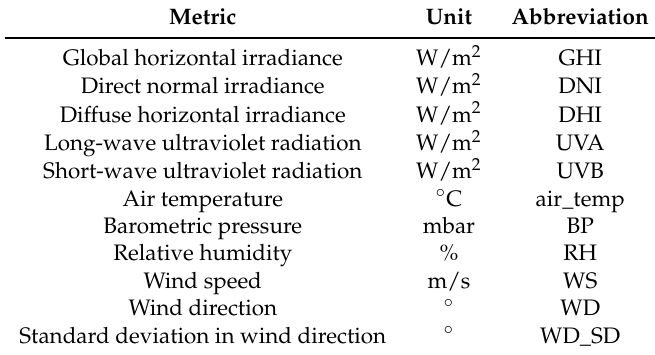
Table 2. Weather metrics recorded at the Southern African Universities Radiometric Network weather station at Stellenbosch